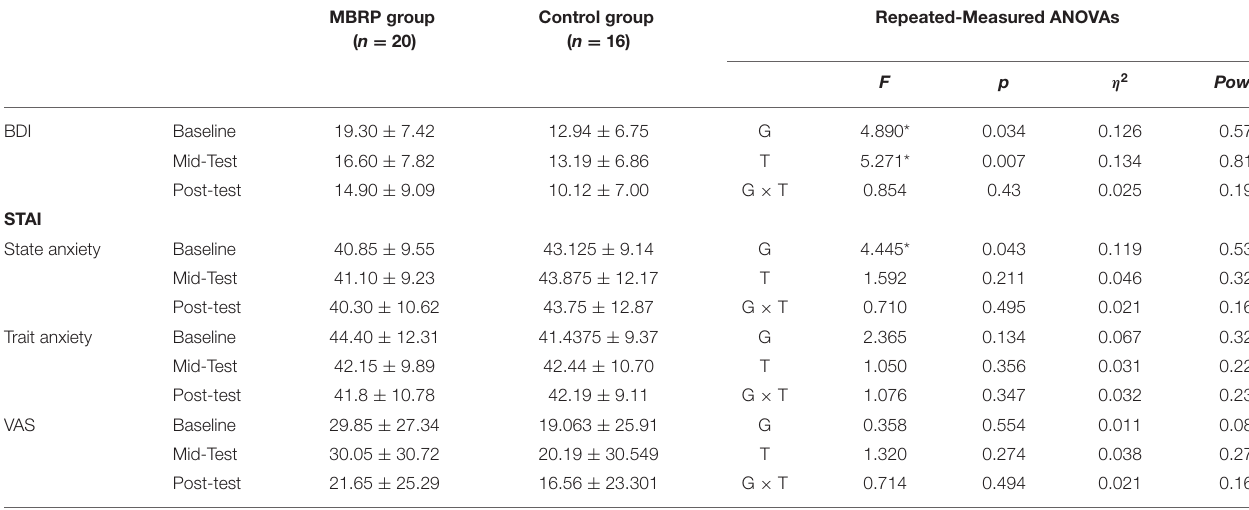
TABLE 2 | The results of the repeated measured ANOVAs in all outcome variables ( N =